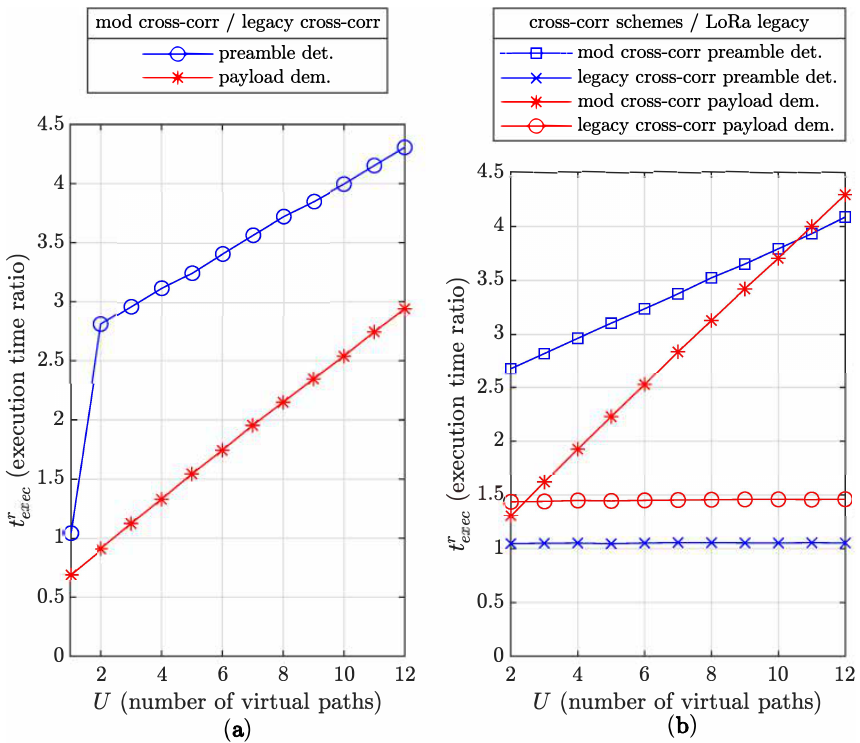
Figure 11. Complexity comparison for preamble detection and payload demodulation between: ( a ) mod cross-corr and legacy cross-corr. ( b ) mod cross-corr and LoRa legacy scheme, legacy cross- corr and LoRa legacy